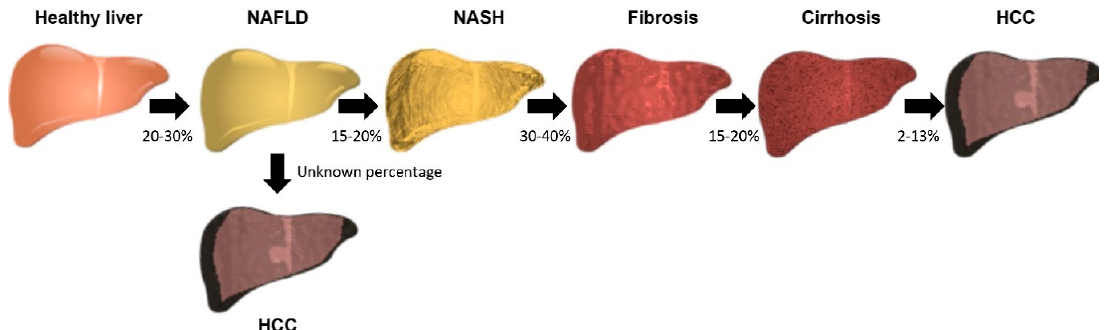
Figure 1. Stages of nonalcoholic fatty liver disease (NAFLD). Liver appearance in the various stages of the disease is schematized to represent the physical changes that accompany disease progression. The percentage of patients progressing from one stage to the subsequent stage is depicted below the arrows. NASH: nonalcoholic steatohepatitis, HCC: hepatocellular carcinoma.